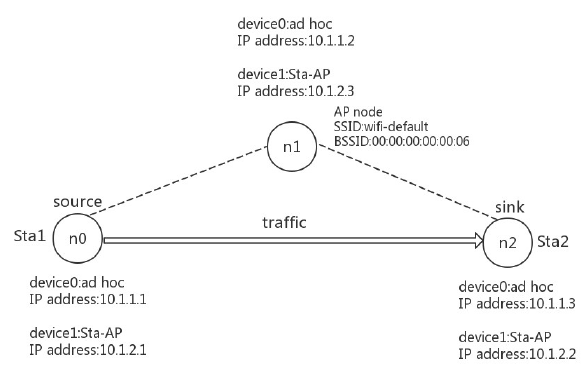
Figure 1. 3 nodes topology.